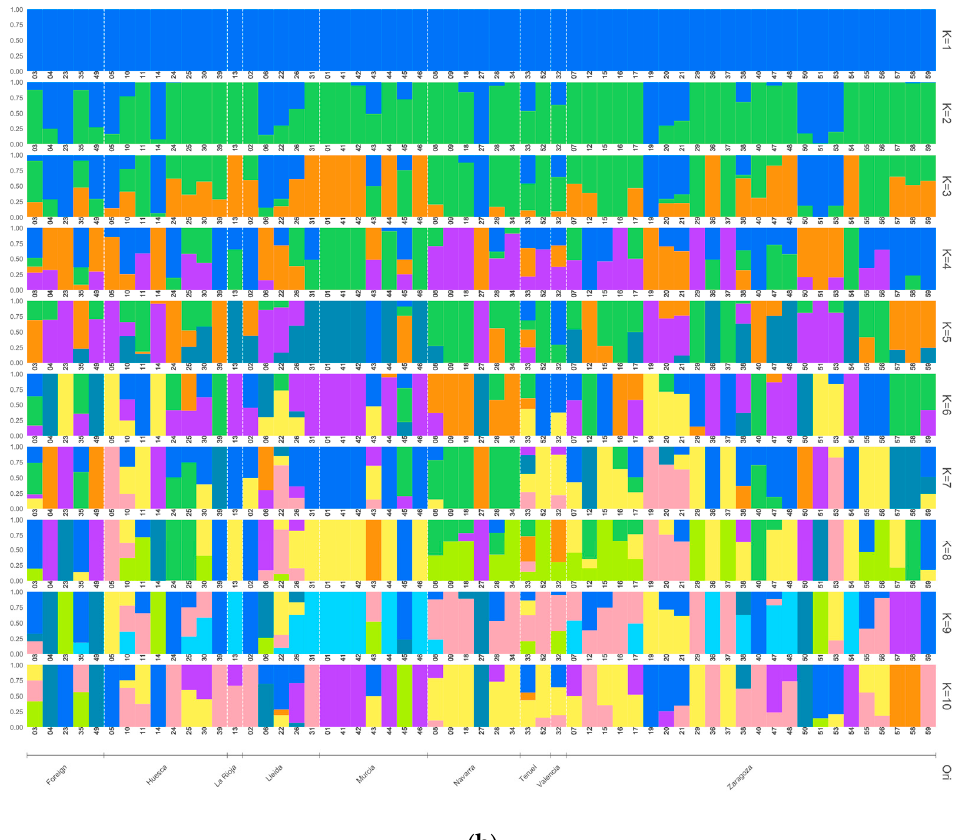
Figure 3. Structure results for k = 1 to k = 10 of the accessions excluding the duplicates: ( a ) placed according to cluster order; ( b ) placed according to geographic origin. The ID numbers can be found in Supplementary Table